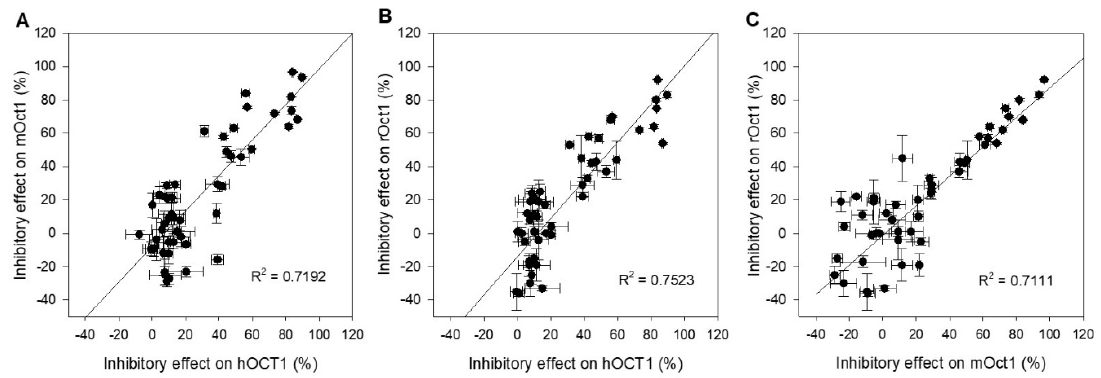
Figure 4. Scatter plot analysis correlating inhibitory effects of ( A ) hOCT1 and mOct1, ( B ) hOCT1 and rOct1, and ( C ) mOct1 and rOct1. The correlation coefficient R 2 value for all three combinations is higher than 0.7, indicating a good correlation between species. Data points represent mean and standard deviation of one individual experiment. Mean values in detail are presented in Tables 1 and 2.